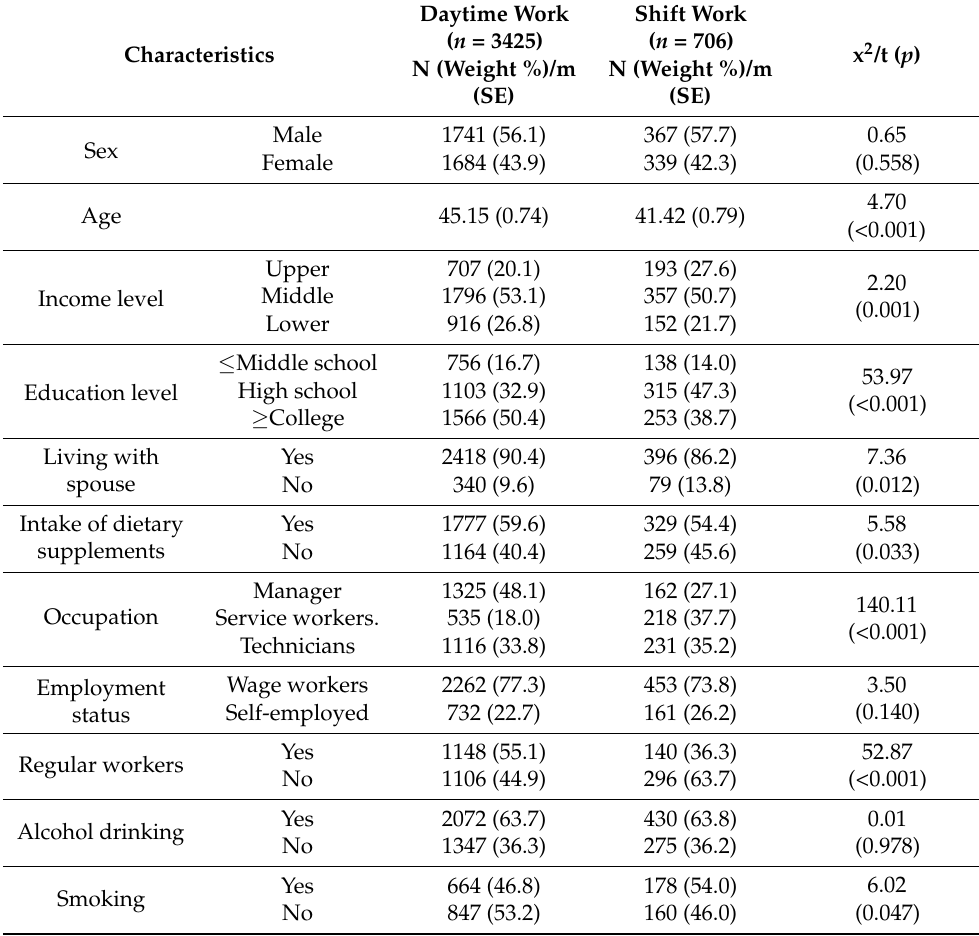
Table 1. Comparison of sociodemographic factors (N =